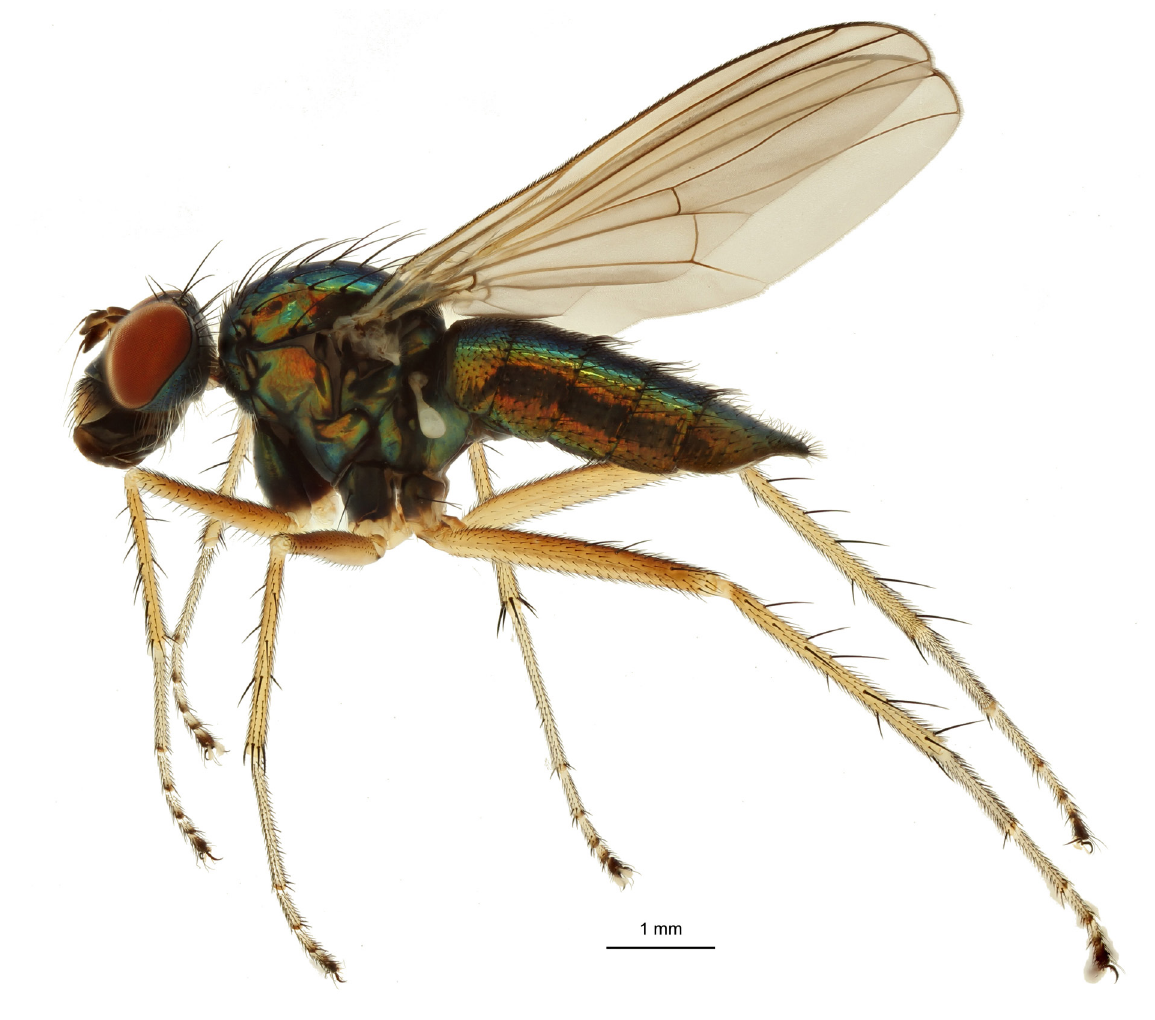
Fig. 6. Thinophilus plektron Samoh & Grootaert sp. nov. Female habitus (Abdulloh Samoh leg., PSUNHM